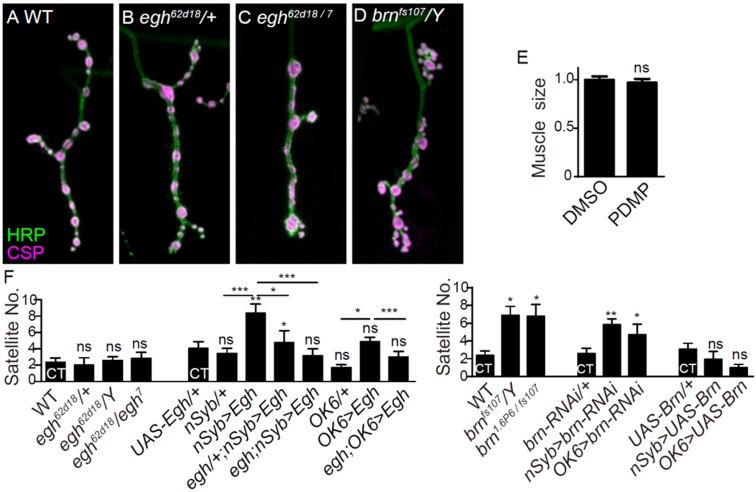
Additional NMJ images and quantifications.(A–D) Images of NMJ4 co-stained with anti-HRP (green) and anti-CSP (magenta) in wild type (A), egh62d18/+ (B), egh62d18/egh7 (C), brnfs107/Y (D). Scale bar: 10 μm. (E) Quantifications of muscle four surface area from wild type with or without D, L-threo-PDMP treatment at 0.5 mg/ml. ns, no significance, one-way ANOVA with Tukey post hoc tests; n ≥ 8 larvae; error bars: s.e.m. (F) Quantifications of satellite bouton number of NMJ4 from different genotypes. ns, no significance, *p<0.05, **p<0.01, ***p<0.001 one-way ANOVA with Tukey post hoc tests; n ≥ 12; error bars: s.e.m.